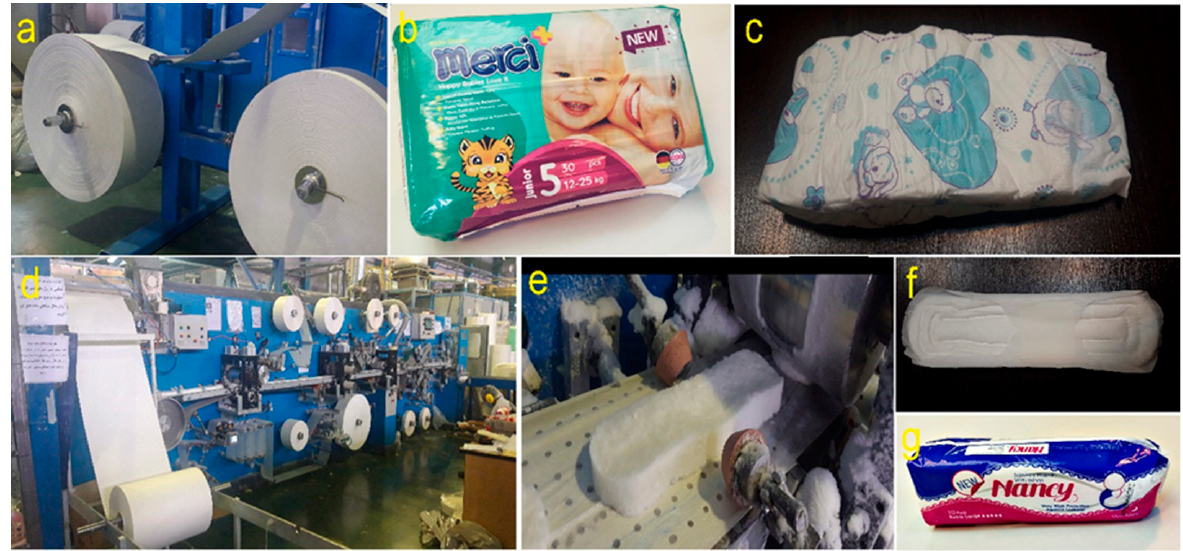
Figure 11. Different stages in production of baby diapers and sanitary napkins. Fluff pulp rolls working on the machine ( a ), baby diaper pack ( b ), baby diaper pad ( c ), BMT machine ( d ), fluff pulp in the shape of sanitary napkin ( e ), sanitary napkin pad ( f ), sanitary napkin pack ( g ).